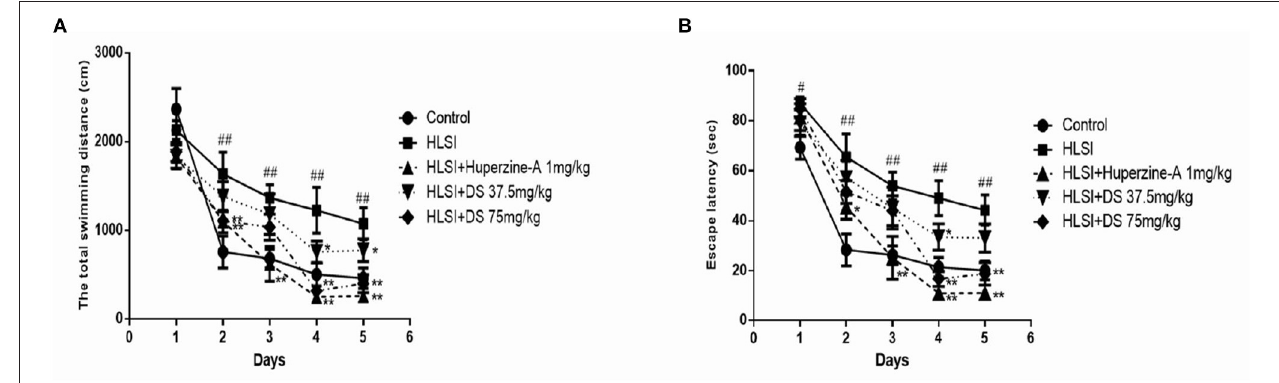
FIGURE 9 | The effects of DS on the spatial memory in the MWM test after HLSI in rats. All values are mean ± SEM ( n = 8–10) for the following: (A) total swimming distance and (B) escape latency. The symbols represent: # p < 0.05 and ## p < 0.01 vs. the control group; * p < 0.05 and ** p < 0.01 vs. the HLSI group.